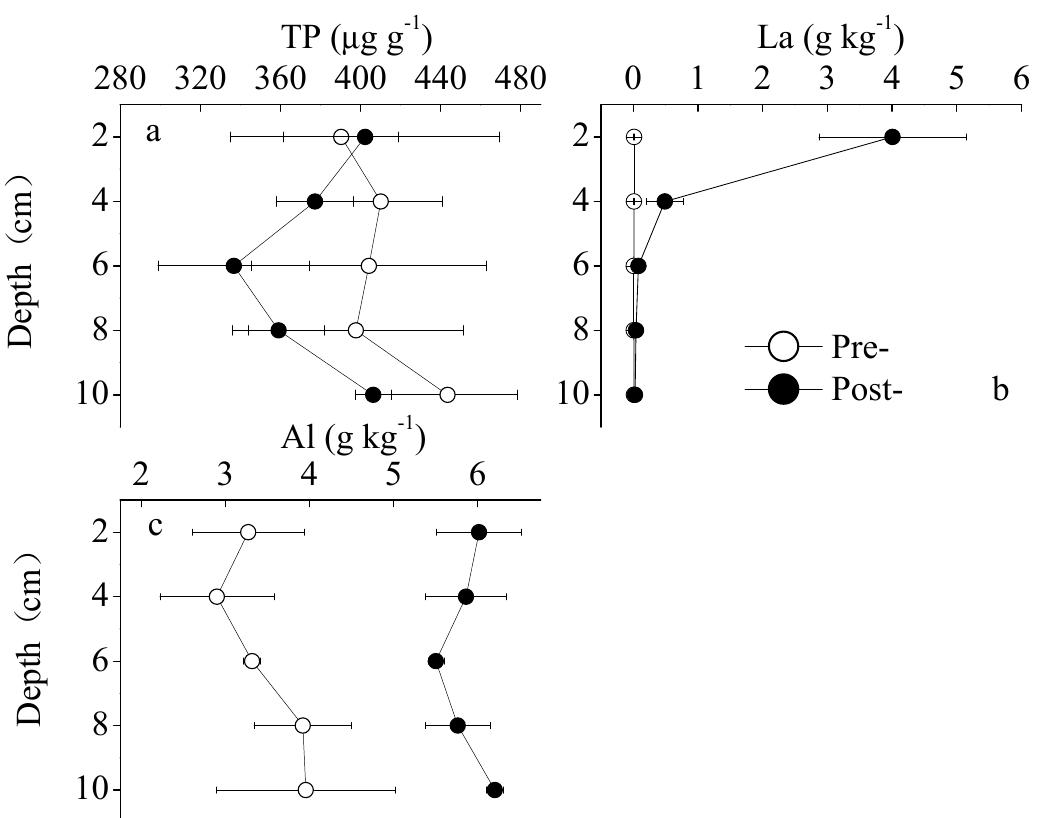
Figure 4. The concentrations of total phosphorus (TP) ( a ), Lanthanum (La) ( b ) and Aluminium (Al) ( c ) in different depths of the sediments in the treatment area of Lake Yanglan in the pre- (open circle) and post- (closed circle) application of PAC and Phoslock ® ( n = 3).